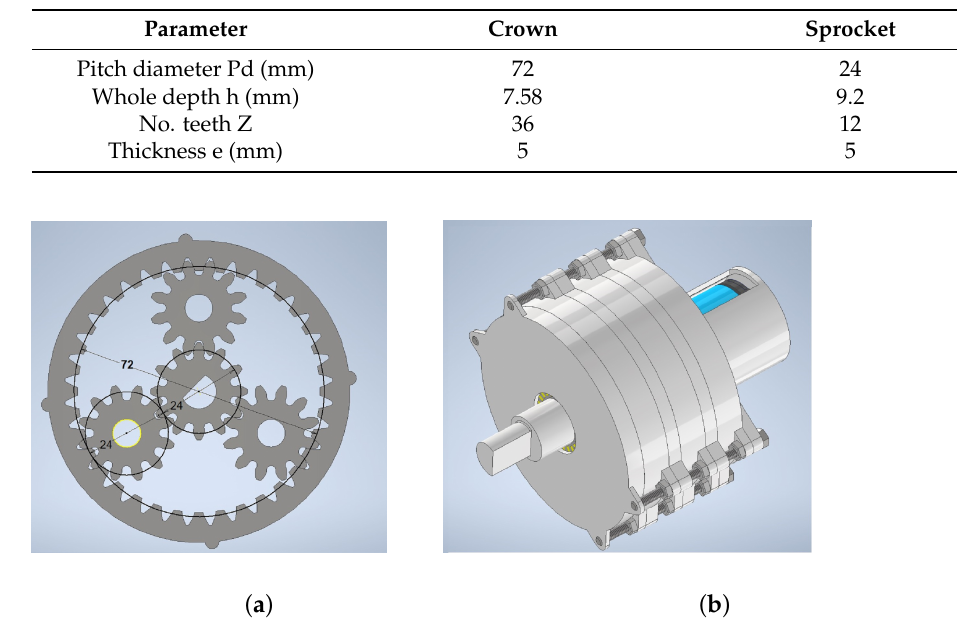
Figure 10. ( a ) Dimensions of the planetary gear set. ( b ) Three stages of planetary gearbox assembly.